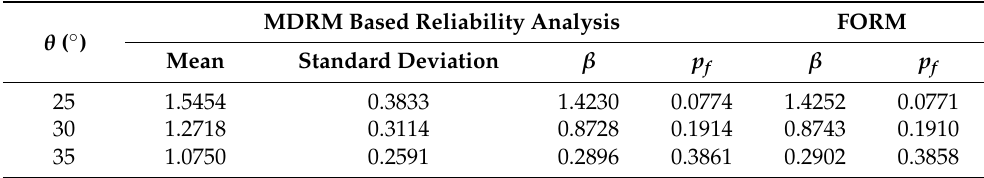
Figure 4. The probability distribution of safety factor in different H. Table 5. Reliability index and failure probability of slope in different θ . θ ( ◦